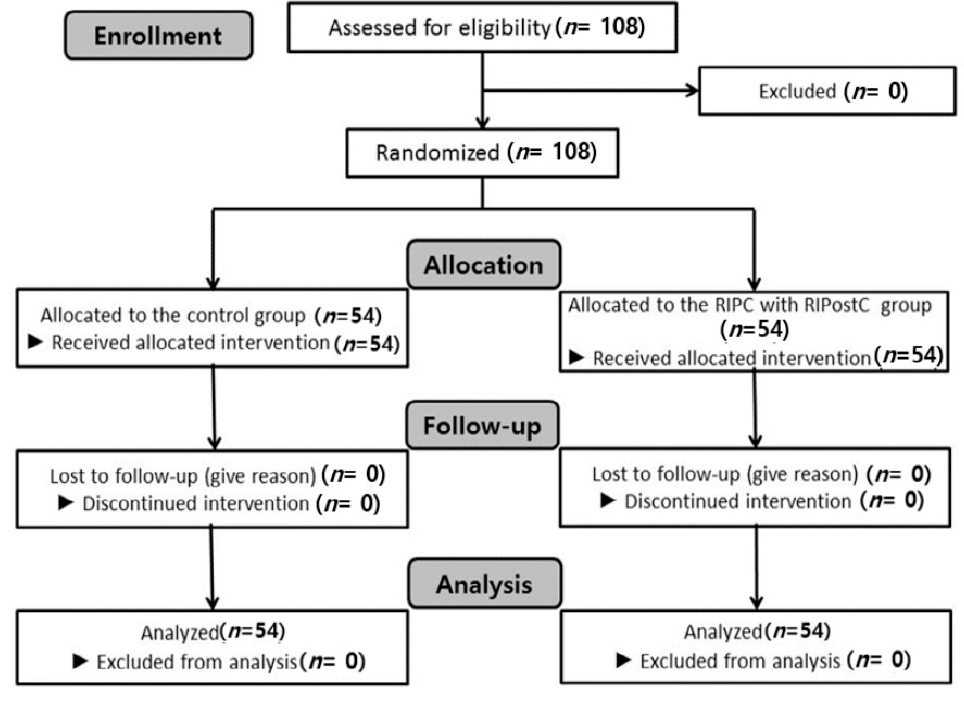
Figure 1. Flow chart of patient enrollment. Table 1. Demographic data.